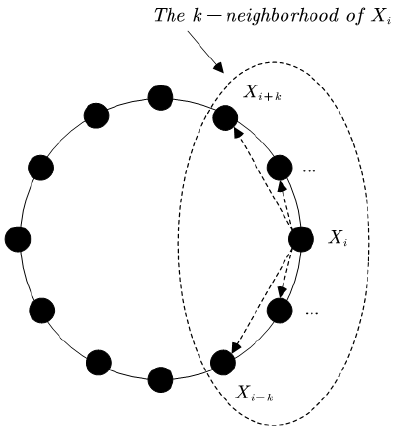
Figure 5. The NA model.